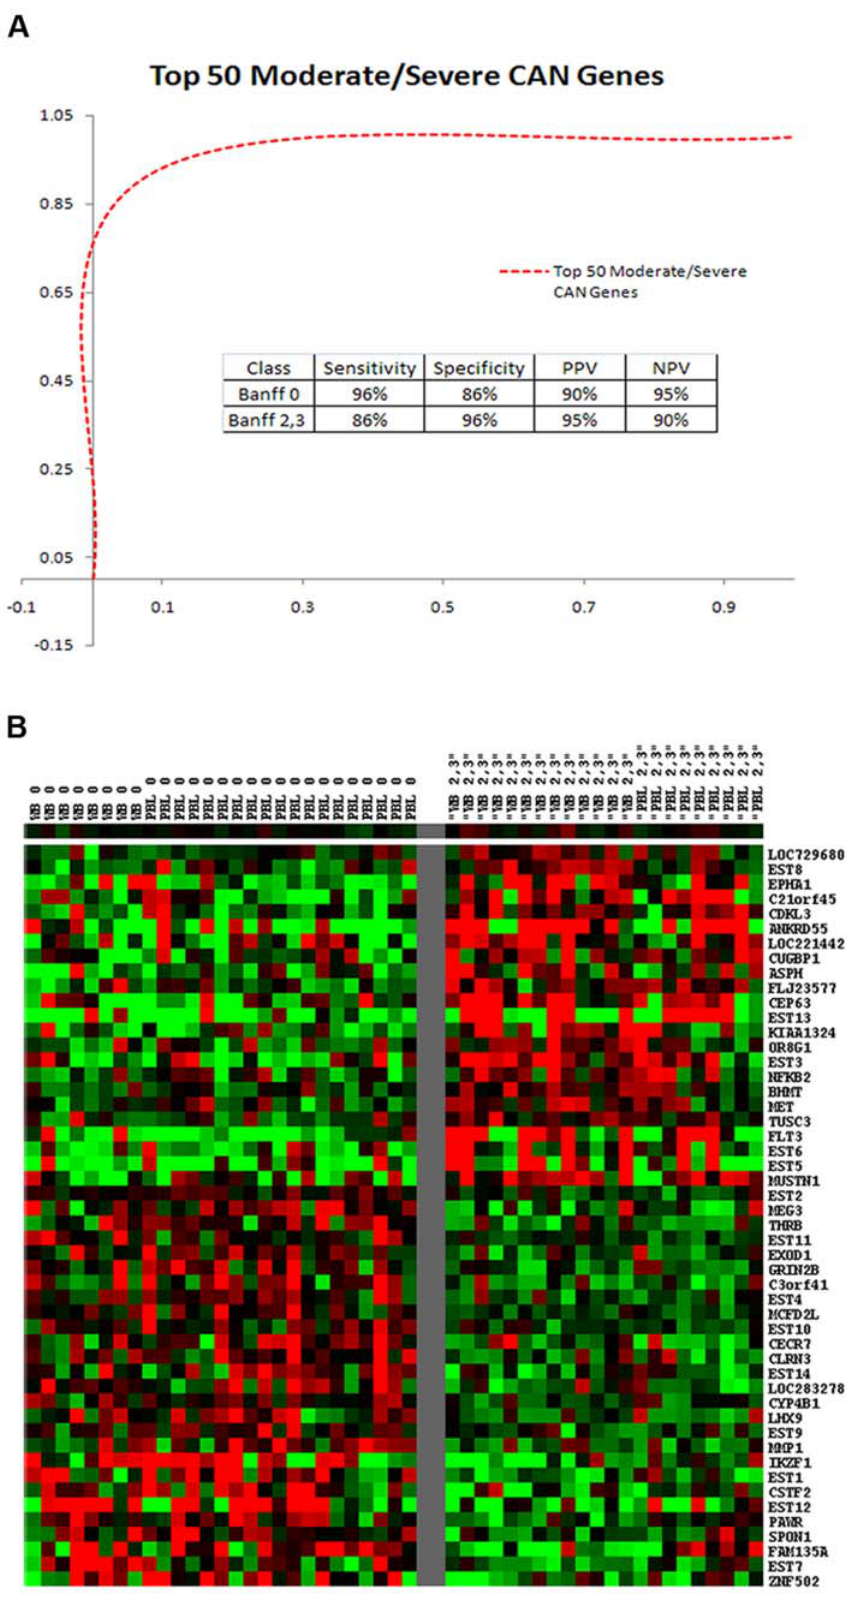
Figure 4. Class prediction analysis of Banff 0 vs. Banff 2,3 (moderate to severe CAN) based on Diagonal Linear Discriminant Analysis for the top 50 Banff 0 vs. Banff 2,3 consensus genes ranked by p values. A) depicts the Receiver Operating Characteristic (ROC) curves and provides the Sensitivity, Specificity, Positive Predictive Value (PPV) and Negative Predictive Value (NPV); B) depicts the heat map classifying Banff 0 vs. Banff 2,3 using the top 50 consensus genes where (red) is up-regulated and (green) is down-regulated. doi:10.1371/journal.pone.0006212.g004 PLoS ONE |